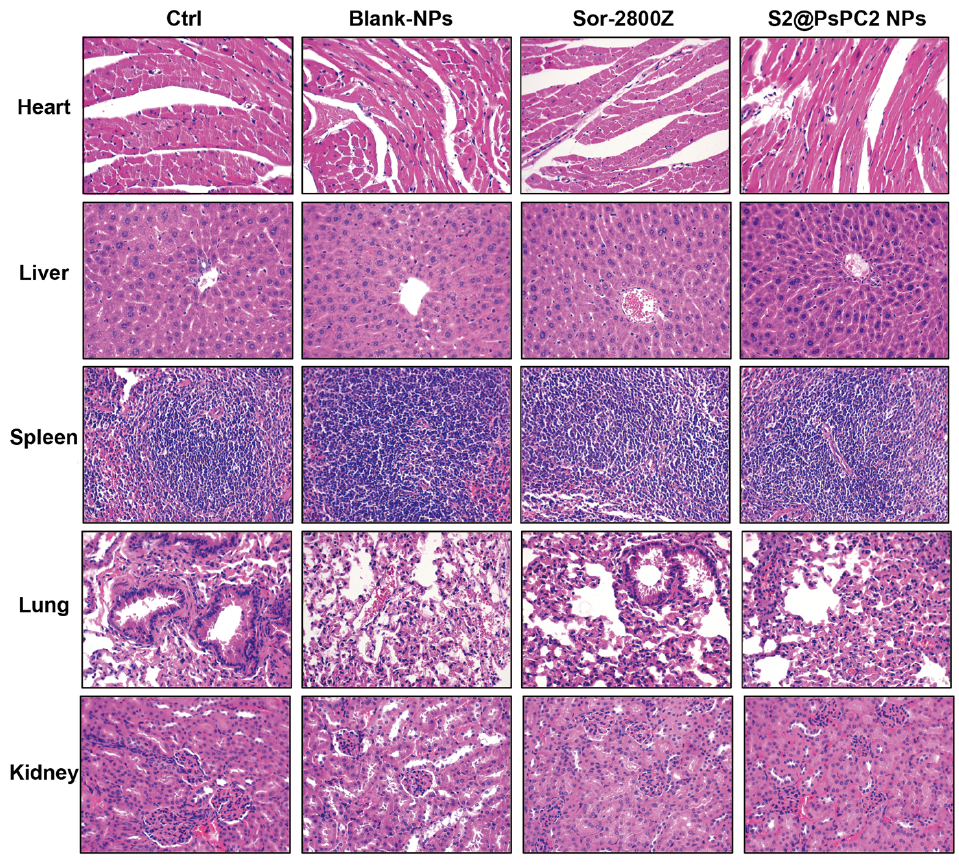
Figure 7. Histological assessment of organs with H&E staining in mice treated with control (PBS), blank NPs, free sorafenib and 2800Z combination (Sor-2800Z), or S2@PsPC2 NPs for 14 days. Images showed representative sections from five mice of each group.